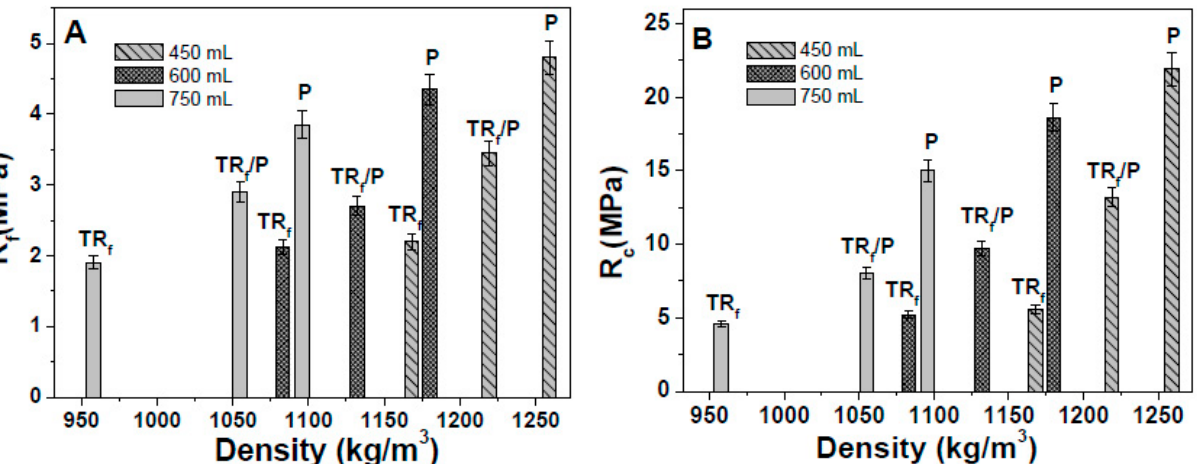
Figure 8. ( A ) Flexural and ( B ) compressive strengths of the TR F and perlite mortars. The Rf and Rc of the control sample were, respectively, 8 ± 1 MPa and 45 ± 2 MPa.